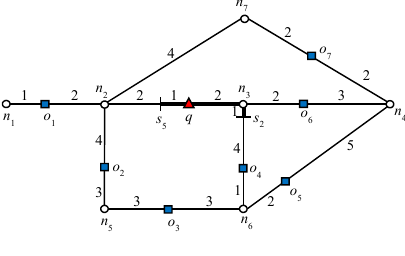
Figure 7. Safe exit points of q.